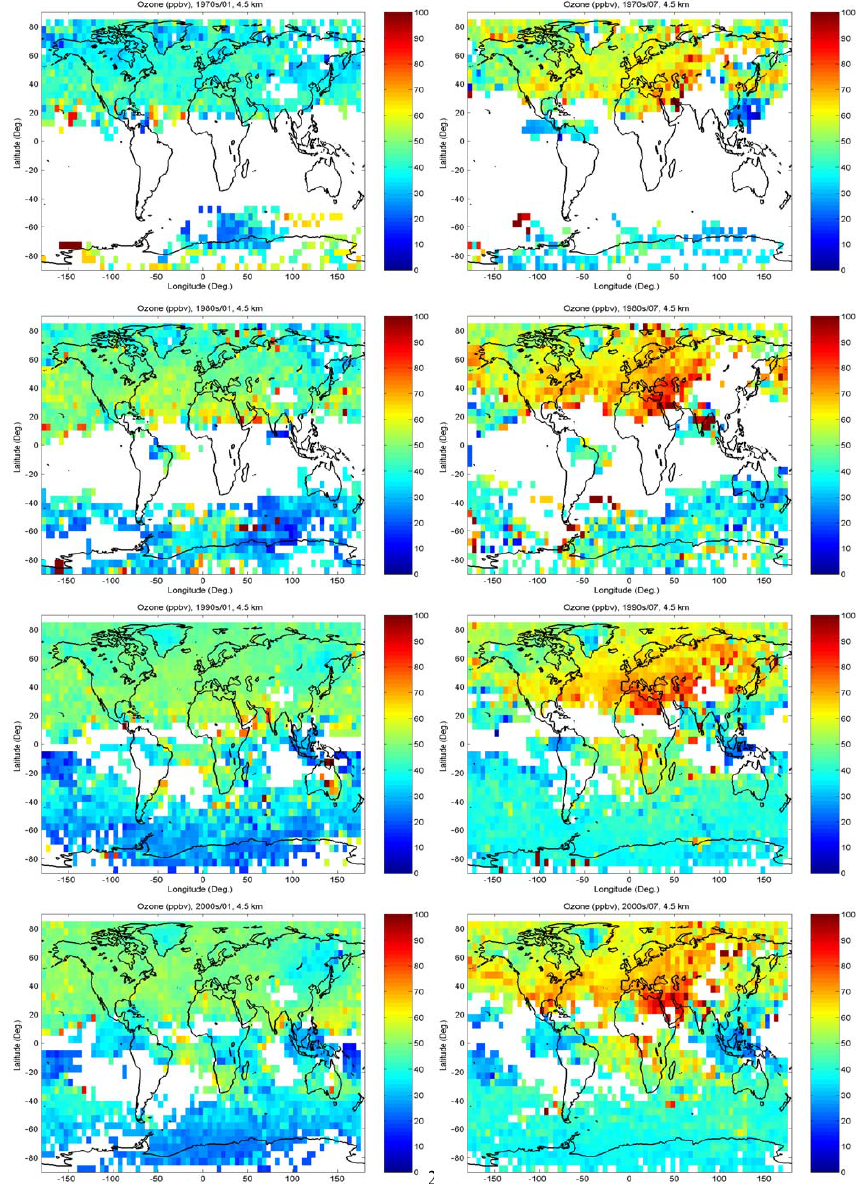
Fig. 8. Unsmoothed (5 ◦ × 5 ◦ pixel averaged) maps at 4–5km, for January (01) and July (07), for each decade since